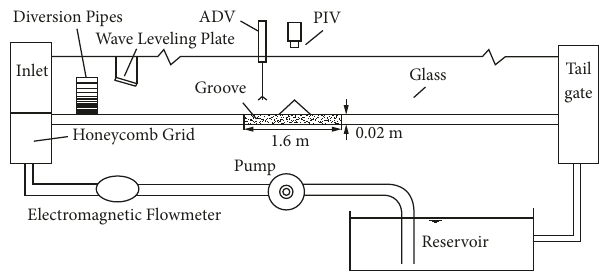
Figure 1: Sketch layout of experiment